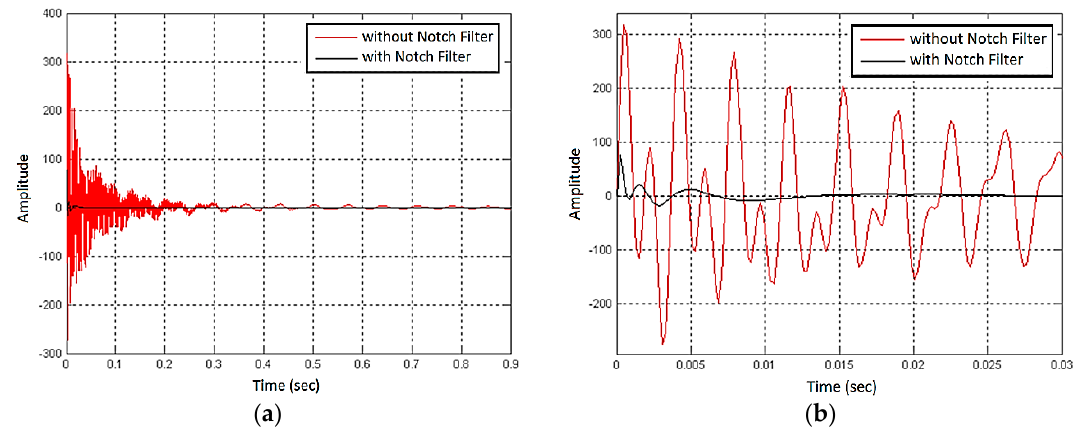
Figure 17. Notch filter control result: ( a ) tracking error of impulse response; and ( b ) zoomed plot of ( a ).